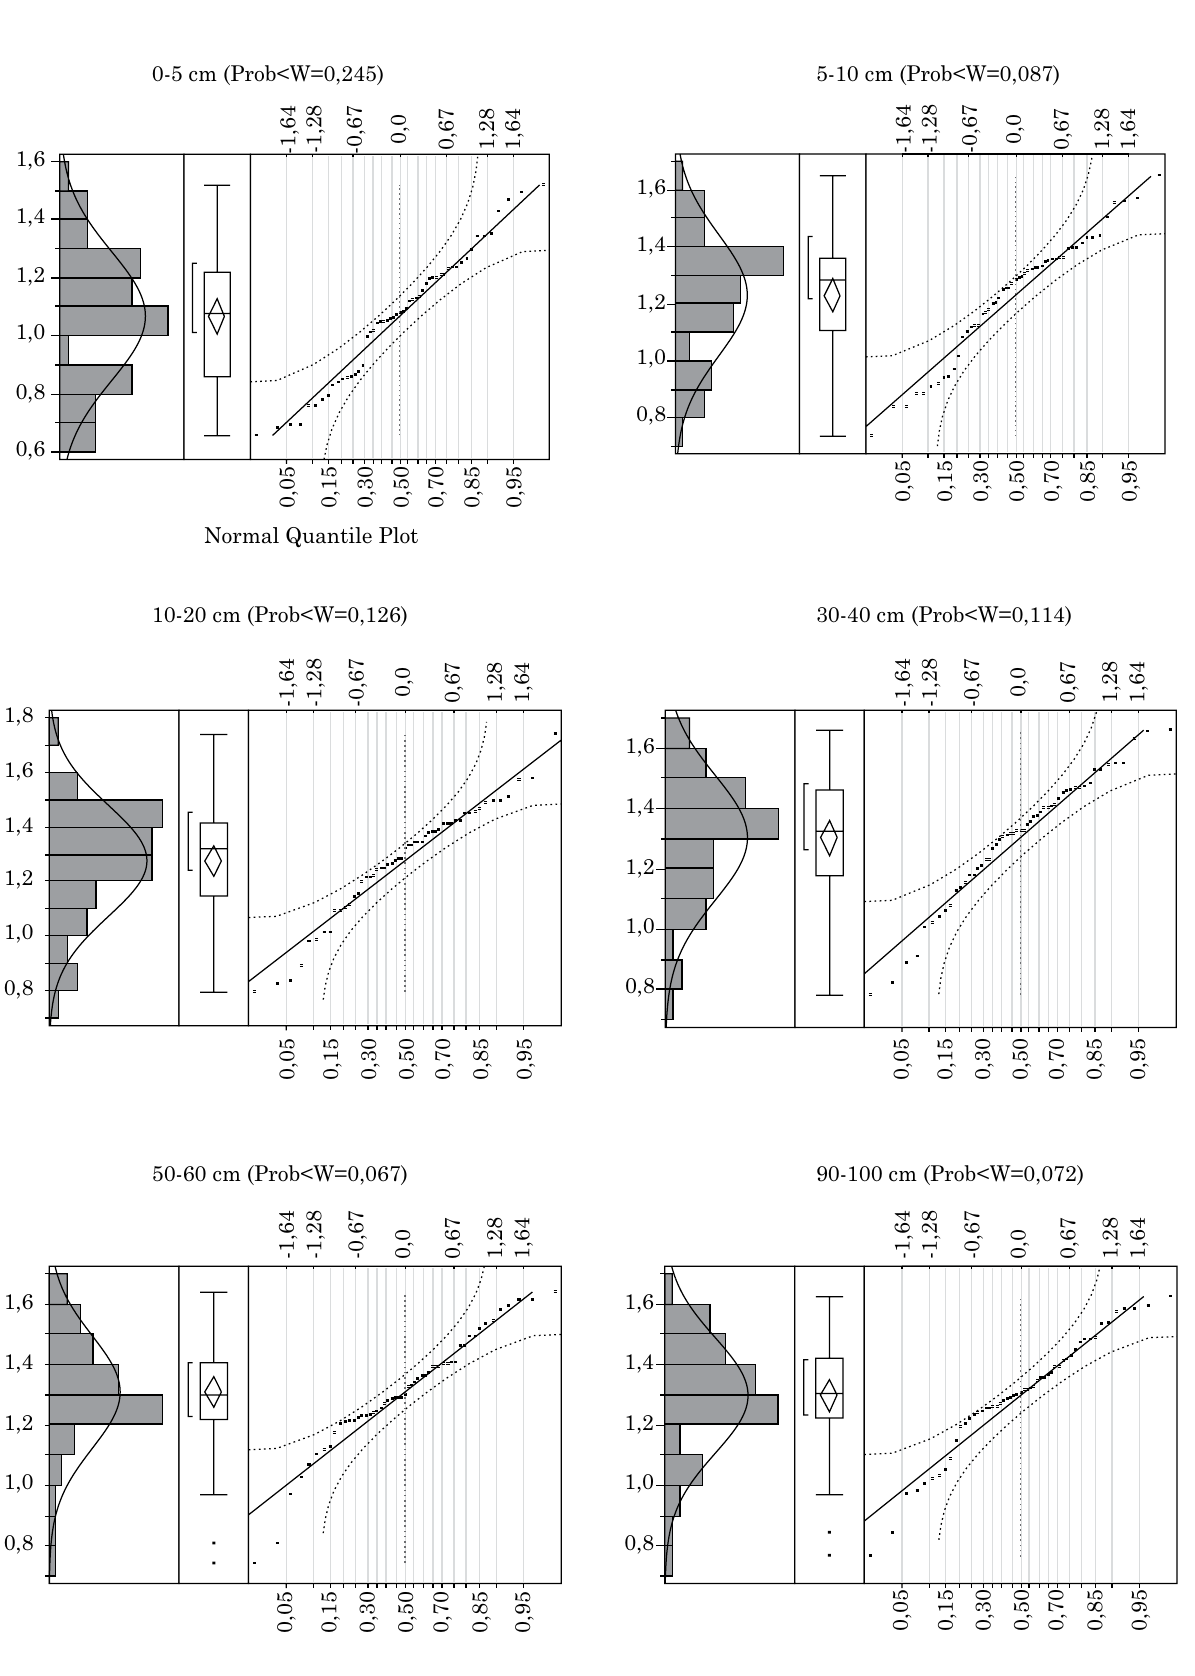
Figura 2. Distribuições de frequência e teste de normalidade de Shapiro-Wilk da densidade do solo por